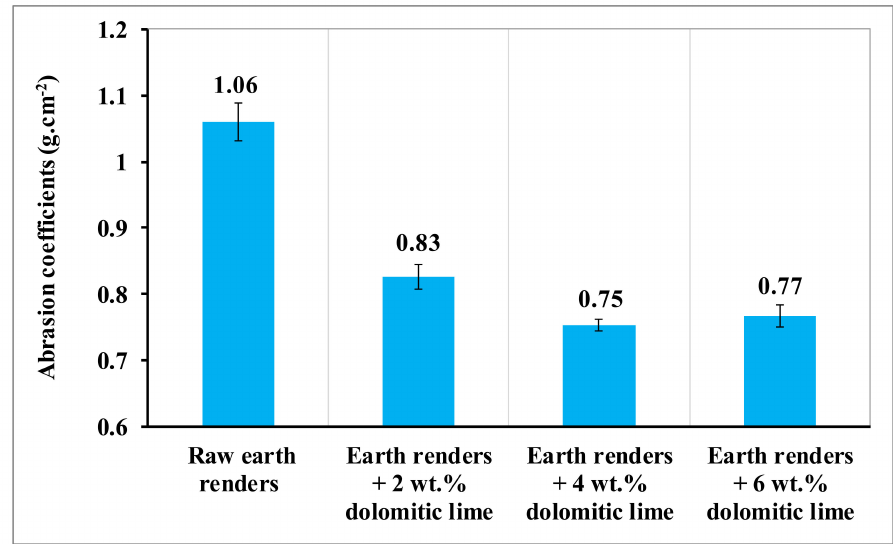
Figure 12. Abrasion coefficient of earth renders versus dolomitic lime.